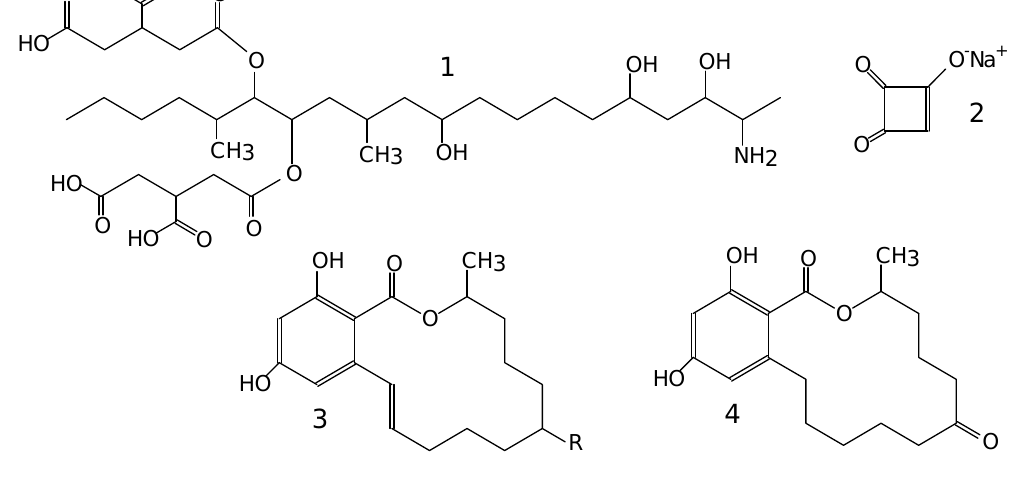
Figure 5: Structures of some Fusarium mycotoxins: FUM B sodium or potassium salt) (2), zearalenone {ZON} (R =O) and zearalenol {ZOL} (R -OH) (3), possible metabolite zearalanone {ZAN}